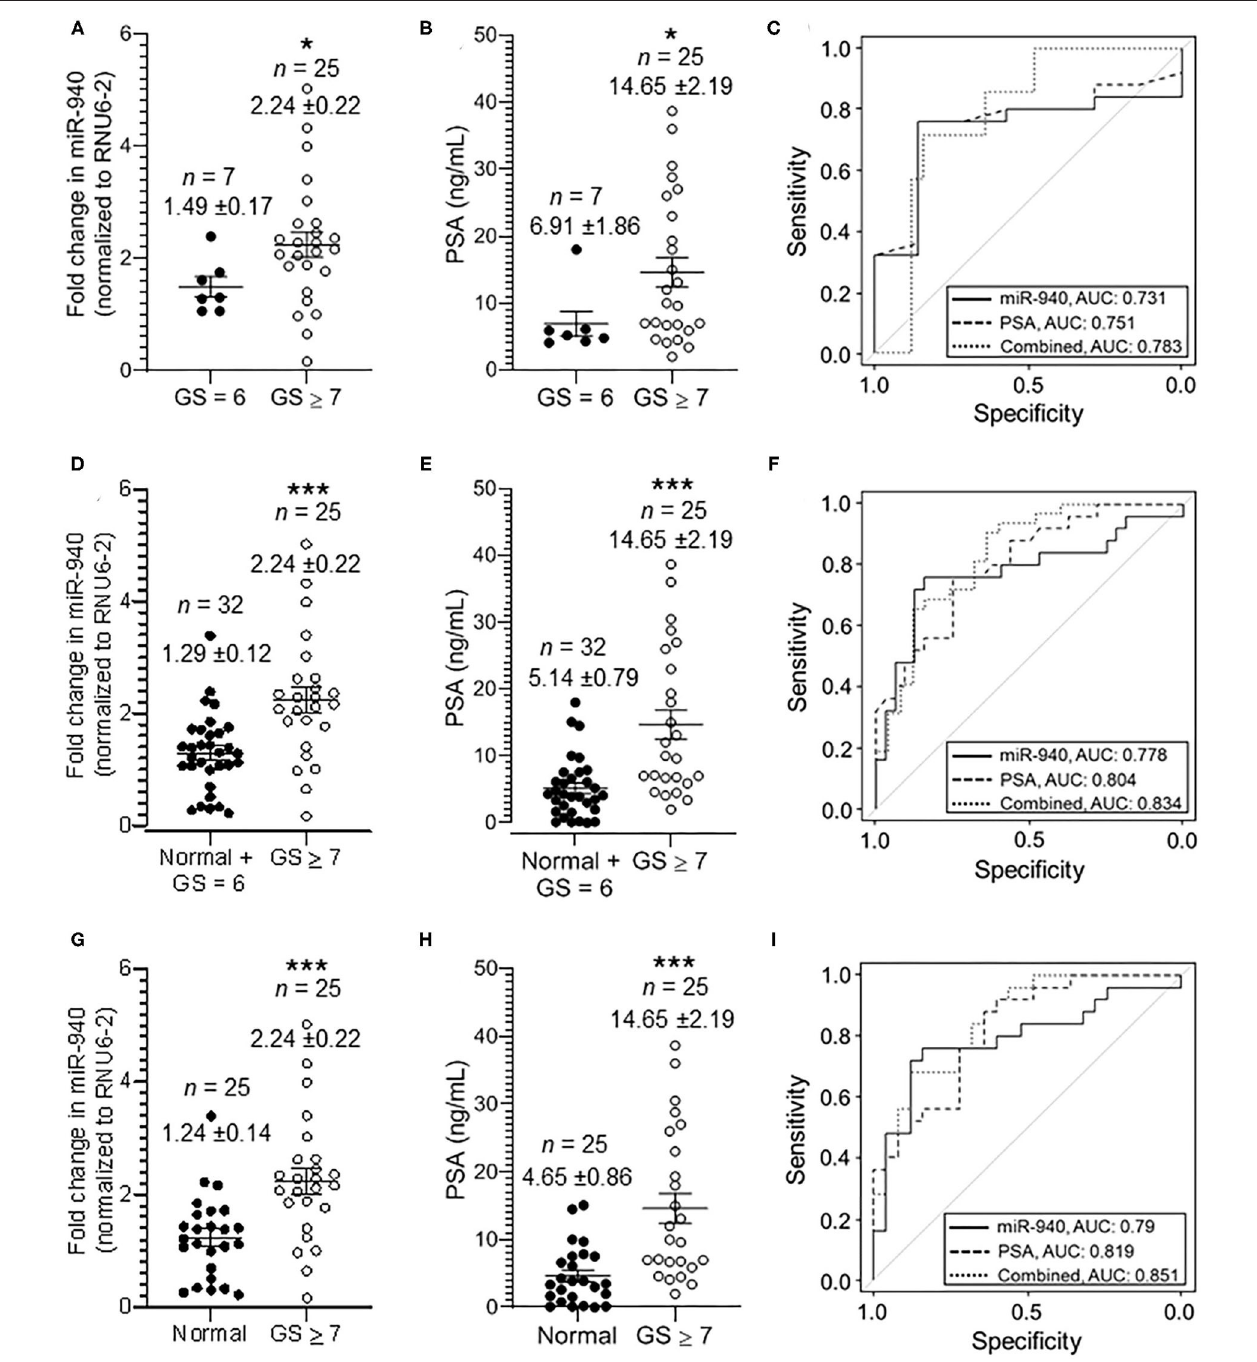
FIGURE 3 | Secreted miR-940 and PSA from serum is significantly higher in patients with clinically significant tumors. (A) Serum from patients who had GS 7 and above in their biopsy were grouped together as clinically significant tumor serum (GS ≥ 7, n = 25) and the ones with biopsy GS 6 as clinically insignificant tumor serum (GS = 6, n = 7). The fold change in the miR-940 was quantified using qPCR. The data are expressed as the mean ± SEM (* p -value = 0.0148; two-tailed Student’s t -test). (B) Scatter plot analysis of PSA expression in serum samples of clinically insignificant ( n = 25) and clinically significant ( n = 32) prostate cancer patients. The data are expressed as the mean ± SEM (* p -value = 0.0134; two-tailed Student’s t -test). (C) ROC curve for both miR-940, PSA, and combined (miR-940 and PSA) comparing clinically insignificant to clinically significant tumors. (D) Scatter plot analysis of miR-940 expression in serum samples of combined normal and clinically insignificant (Normal + GS 6, n = 32) tumors and clinically significant tumors (GS ≥ 7, n = 25) patients. The data are expressed as the mean ± SEM (*** p- value = 0.0006; two-tailed Student’s t -test). (E) PSA expression in serum samples of combined normal and clinically insignificant (Normal + GS 6, n = 32) tumors and clinically significant (GS ≥ 7, n = 25) tumors patients. (*** p -value = 0.0003; two-tailed Student’s t -test) (F) ROC curve for fold change in miR-940 to determine clinically significant cancers (GS ≥ 7) vs. normal and clinically insignificant cancers (healthy controls + GS = 6). (G) Scatter plot analysis of